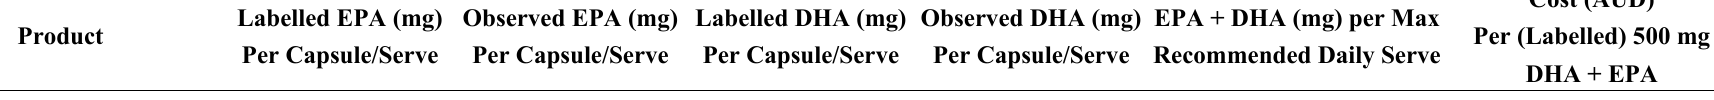
Table 3. Observed versus manufacturer labelled EPA and DHA values of selected fish and krill oil nutriceutical categories and products (labelled and values are rounded to two significant figures). Capsules or subsamples from two separate batches of each product were pooled for each FA analysis, except for Blackmores Omega Liquid Fish Oil for which only a single batch number could be